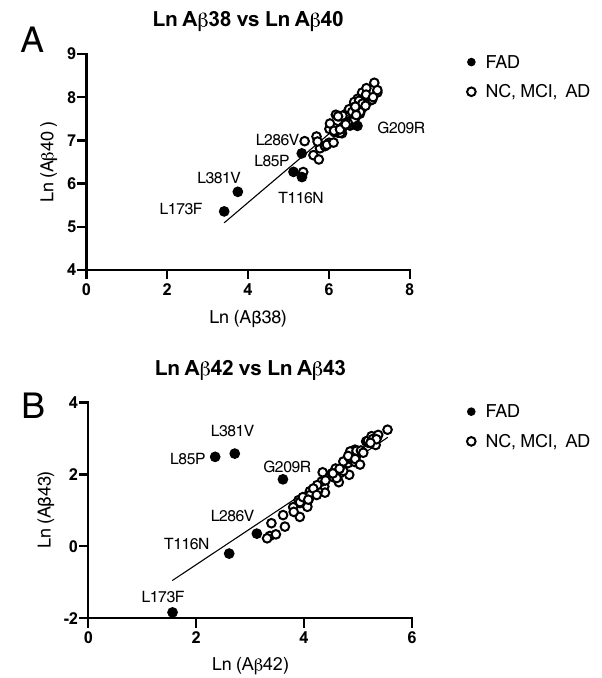
Fig. 1 The relationship between the level of each A β in the CSF from FAD participants and the levels in cognitively normal controls, MCI participants, and AD participants. A The levels of Ln A β 40 were proportional to Ln A β 38 in all subjects. B The levels of Ln A β 43 were proportional to Ln A β 42, except for the PS1 mutation in L85P, G209R, and